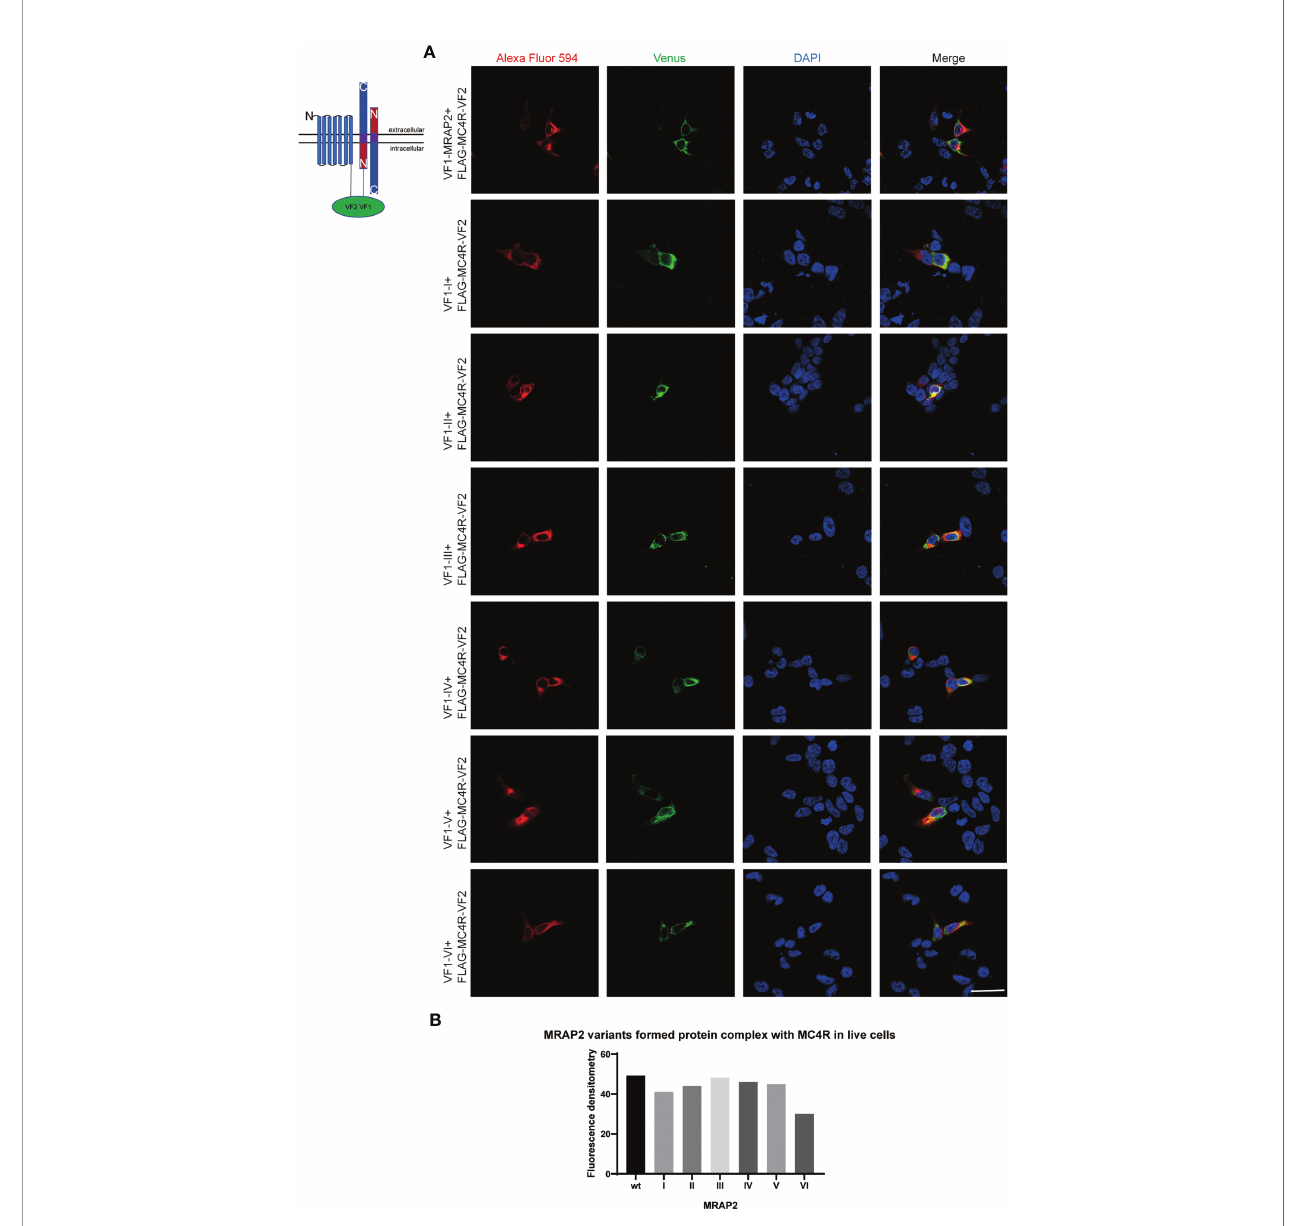
FIGURE 7 | Melanocortin receptor accessory protein 2 (MRAP2) and all the variants formed protein complexes with melanocortin-4 receptor (MC4R). HEK293 cells were transfected with plasmids encoding VF1-X-FLAG and FLAG-MC4R-VF2. Alexa Fluor 594 ( red ) indicated the fl uorescent secondary antibody. Venus fl uorescence ( green ) indicated the MRAP2 antiparallel homodimers. Nuclei stained with DAPI are shown in blue . All three channels were merged in the last photo of the panel . Scale bar , 50 m m. (B) Fluorescence densitometry analysis on the images in (A) . Each data column represents the mean ± SEM of three replicates ( N =